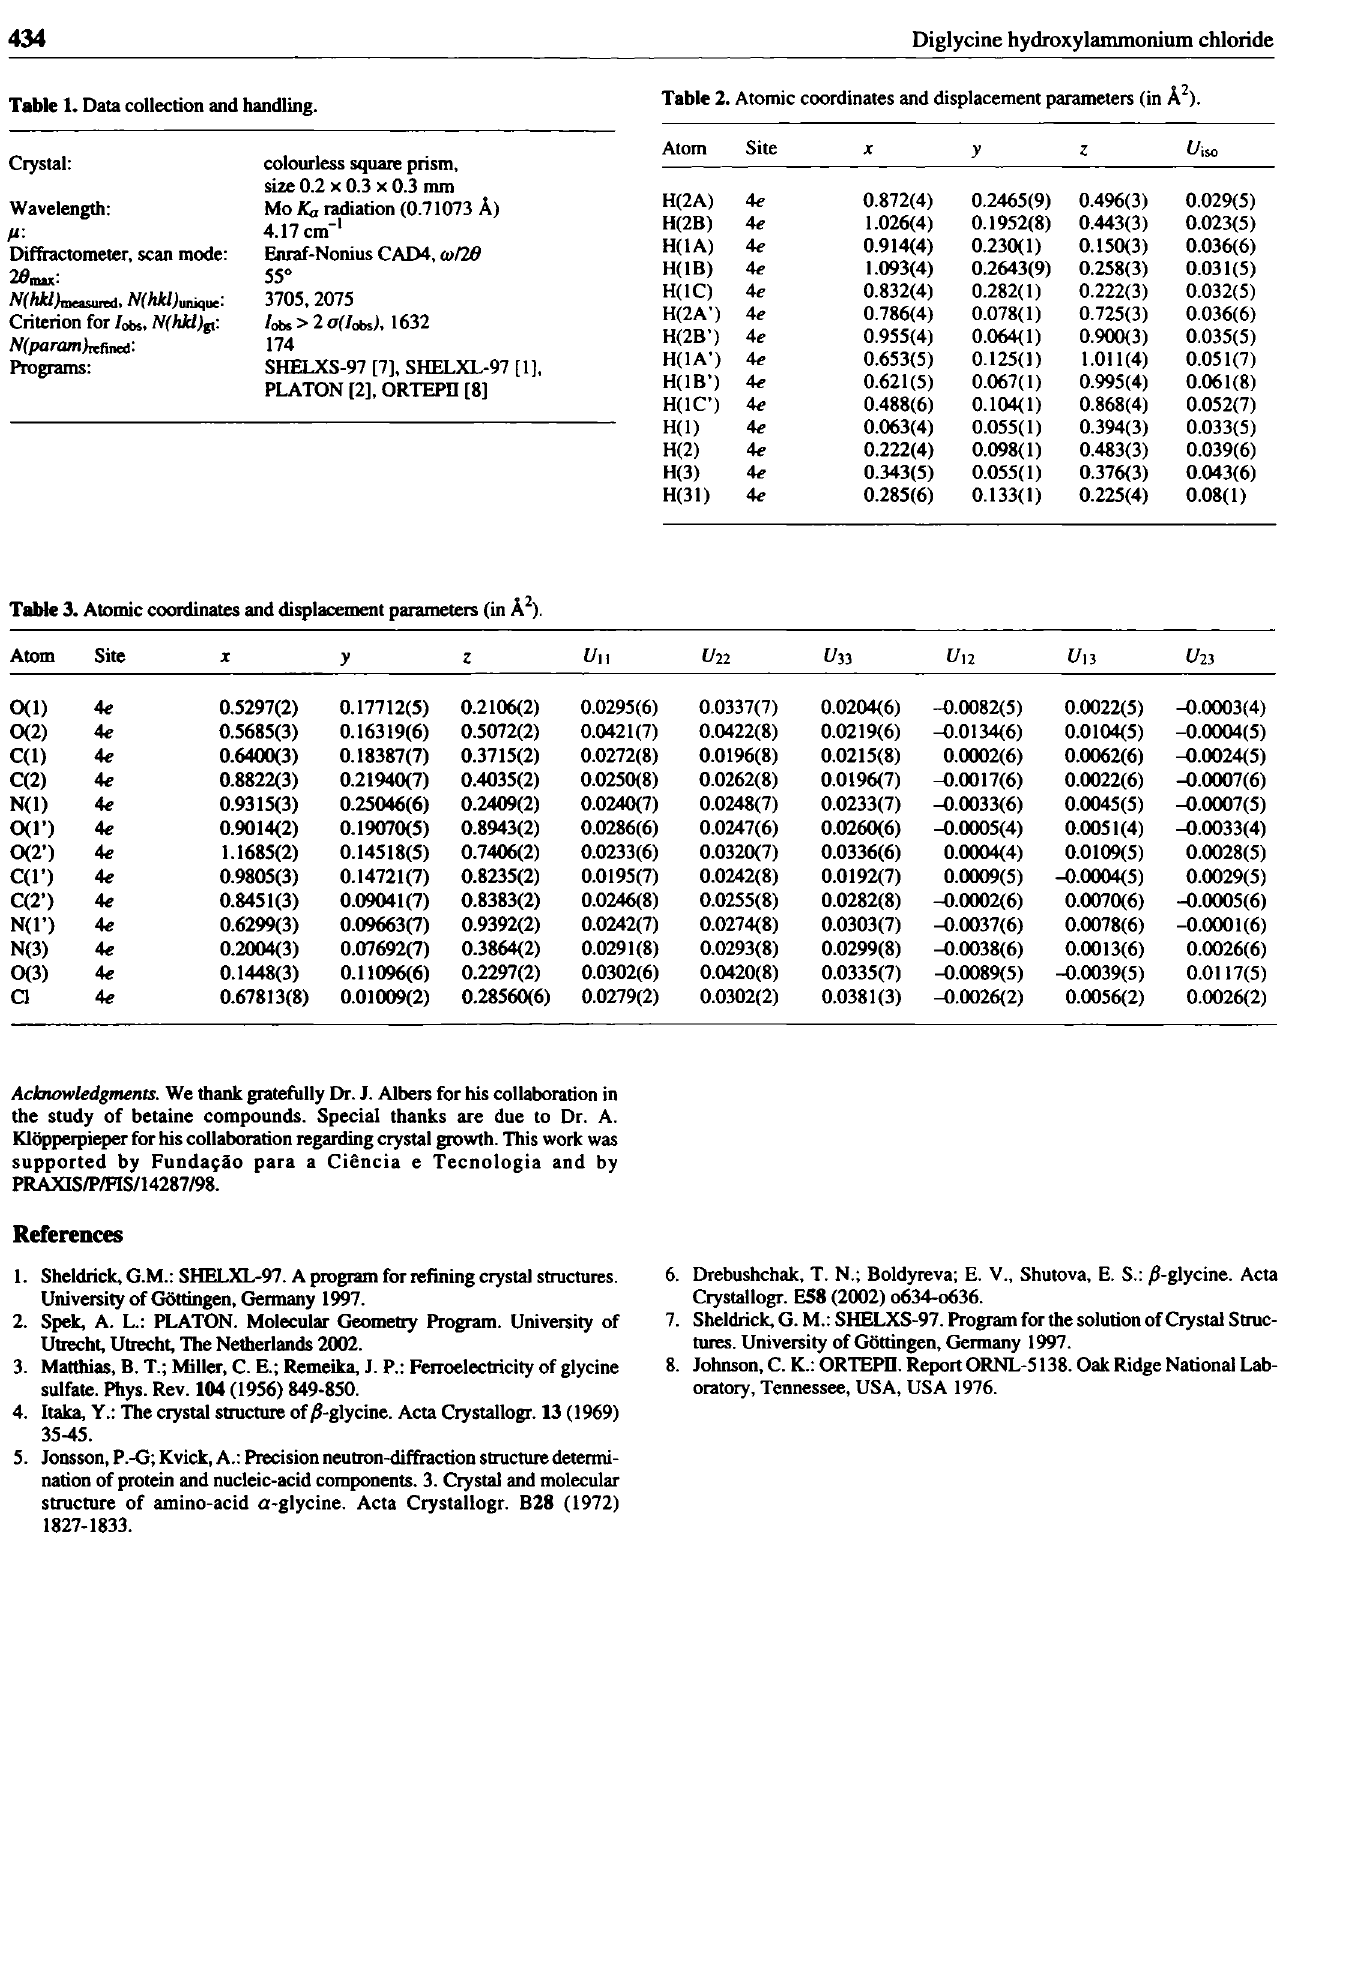
Table 1. Data collection and handling. Table 2. Atomic coordinates and displacement parameters (in A